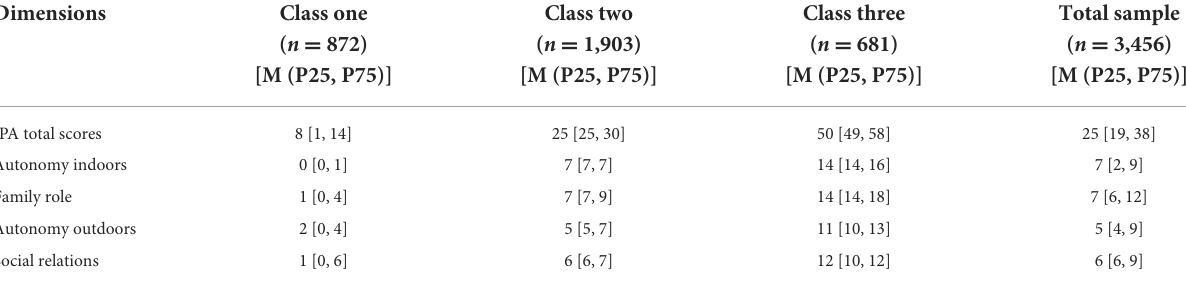
TABLE 3 Four dimensions for different